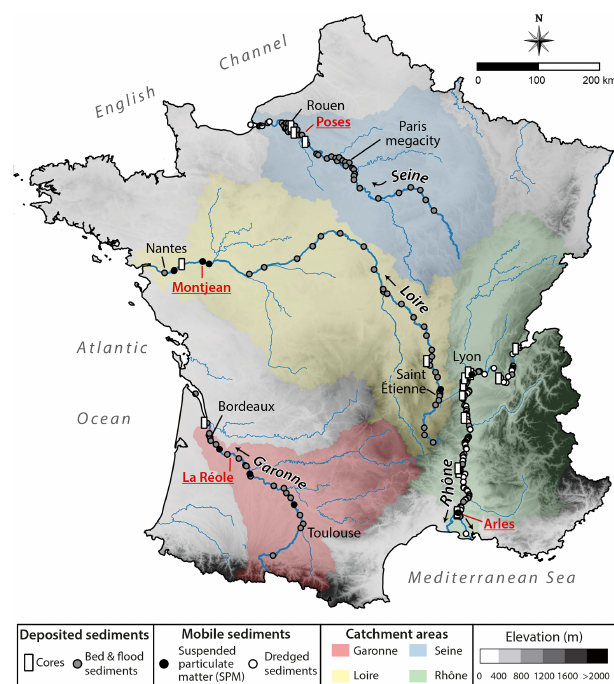
Figure 1. Location of sampling stations along the four main French rivers (Garonne, Loire, Rhône, Seine). Main cities are denoted in black, whereas locations mentioned in red and underlined correspond to the four stations where specific flux was